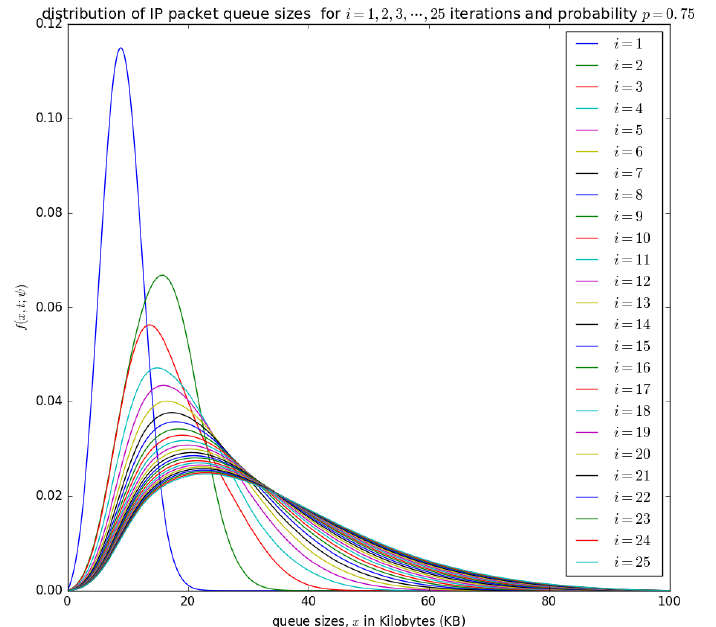
Figure 16. The distribution of the aggregation queue size, f ( f ( x , t ; ψ )) if p = 0.75 for consecutive iterations as in Equation (18) i = 1 . . .